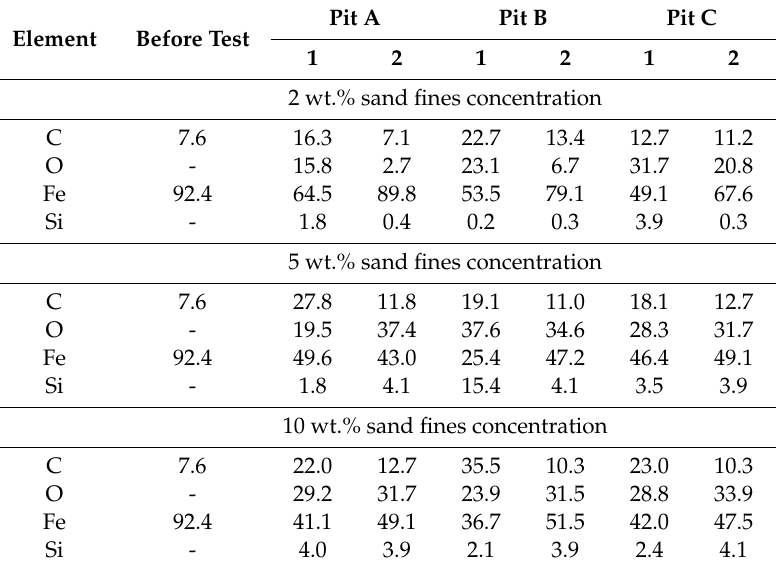
Table 3. Weight percentages obtained by EDS.